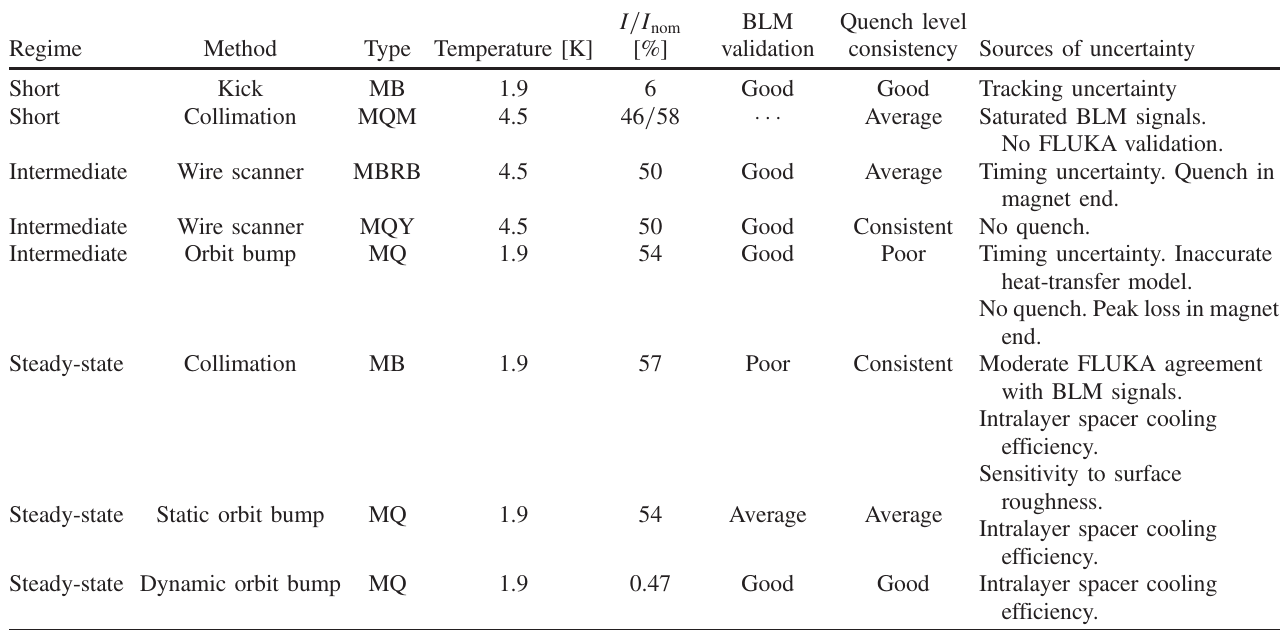
IX. Overview of the presented analyses. BLM validation indicates the level of agreement between particle-tracking and particle-shower simulations with BLM data. Quench-level consistency indicates the agreement between quench-level data obtained from particle-shower simulation results with the electrothermal estimates. “ Good ” indicates agreement within 20% – 30%, “ average ” around 50%, and “ poor ” larger than